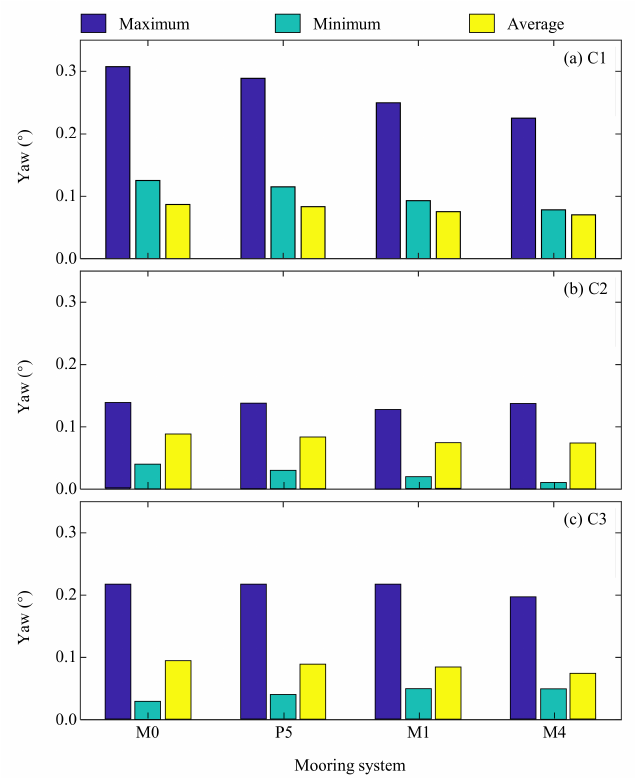
Figure 21. Maximum, minimum, and average values of wind turbine yaw movement time series with M0, P5, M1, and M4 when under: ( a ) C1; ( b ) C2; ( c )